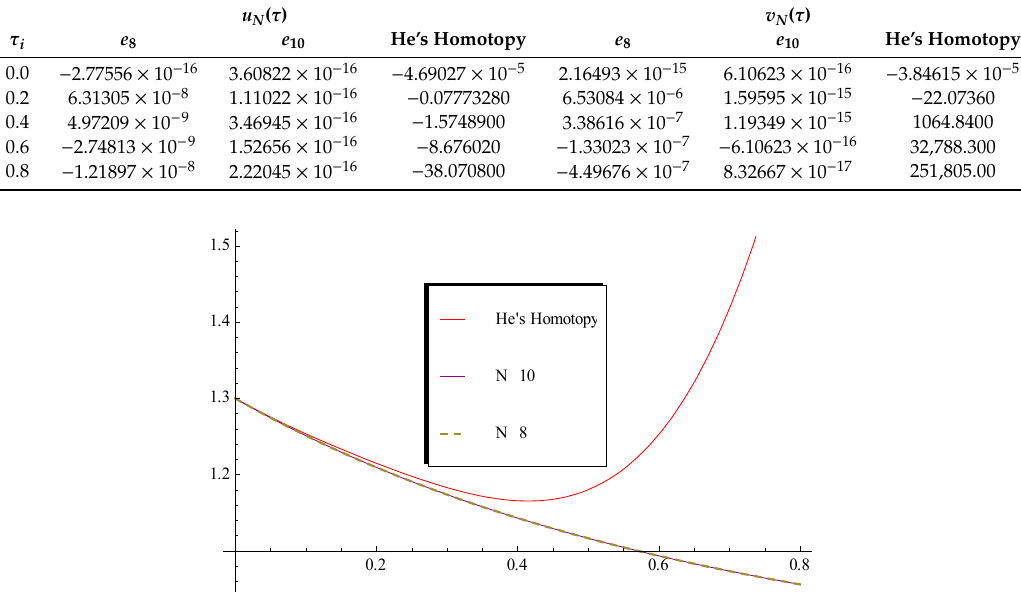
Figure 7 . Approximate solution